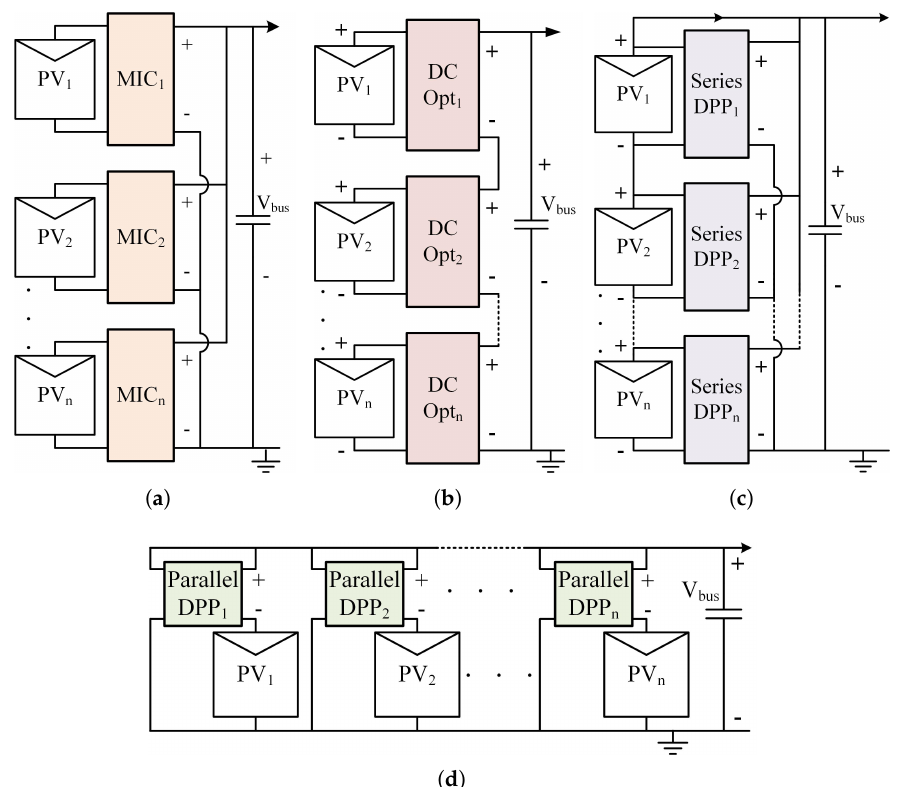
Figure 1. Photovoltaic (PV) systems with ( a ) module-integrated converters (MICs); ( b ) direct current optimizers (DC Opt); ( c ) series differential power processing (DPP) converters; and ( d ) parallel DPP